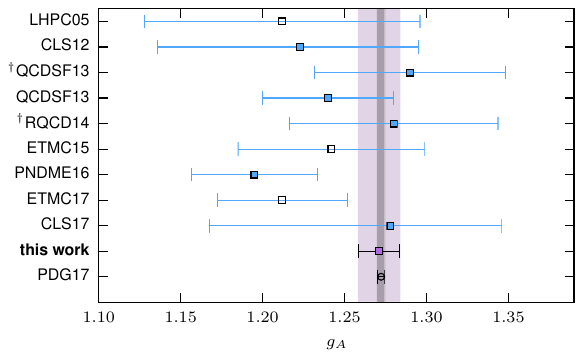
Figure 7. Comparison of the estimate of g A from Ref. [8] with other recent determinations. See Ref. [8] for references to the other estimates. Results with closed symbols have included an extrapolation to the continuum limit, while results with open symbols have only included extrapolation to the physical pion mass. To guide the eye, the vertical magenta band is the full uncertainty from Ref. [8], while the vertical gray band is the ex- perimental